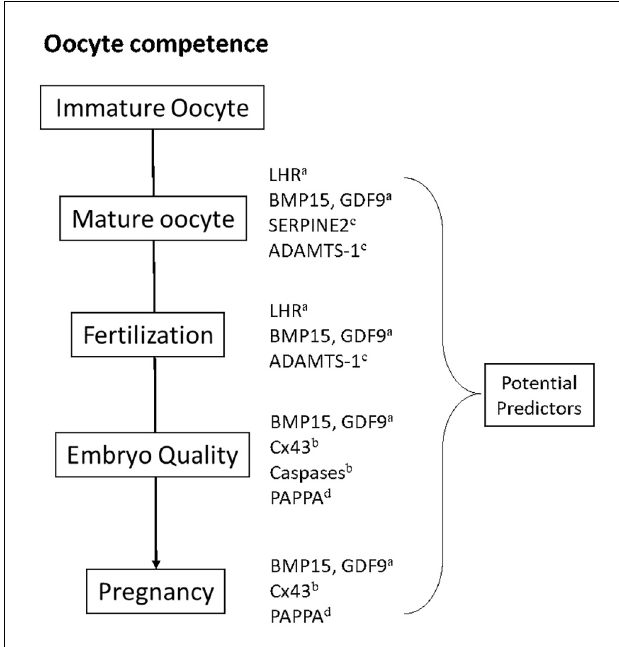
FIGURE 1 | Oocyte competence in IVF could be defined as the ability of an oocyte to achieve the mature oocyte stage, fertilization, embryo stage, and ultimately pregnancy. Expression of the COC-derived genes discussed in this study have exhibited significant predictive values toward the respective IVF stages. a , b , c , d refers to the occyte maturation process that the gene regulate: a Nuclear maturation, b Apoptosis, c Extracellular matrix remodeling, d Steroid